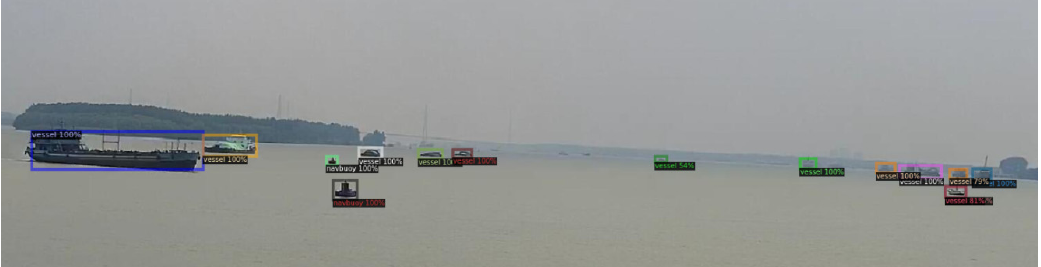
Figure 11. Visual detection result.